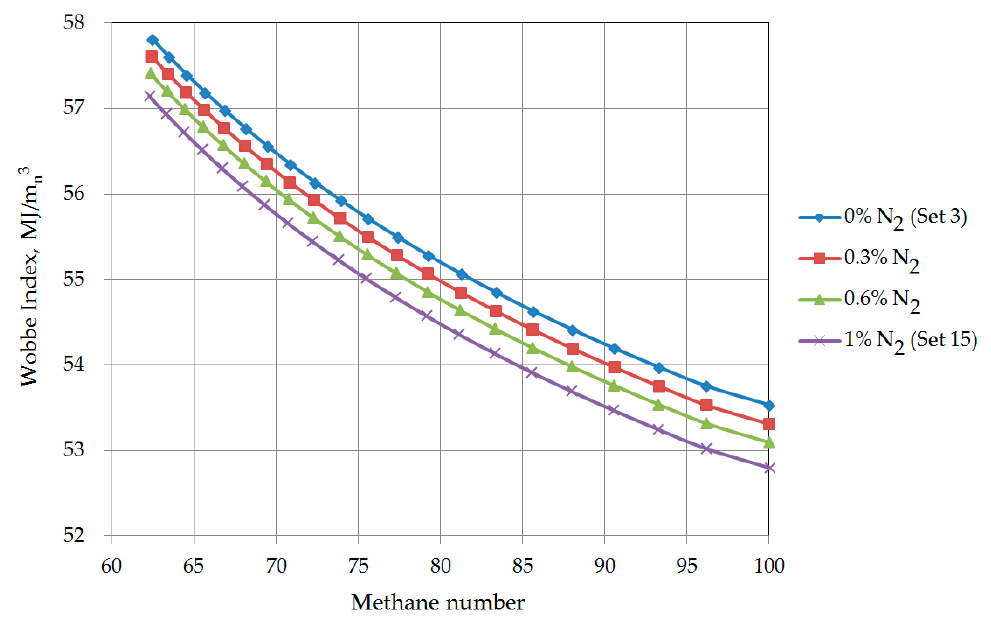
Figure 15. Wobbe Index as function of methane number for composition sets, which contains nitrogen.